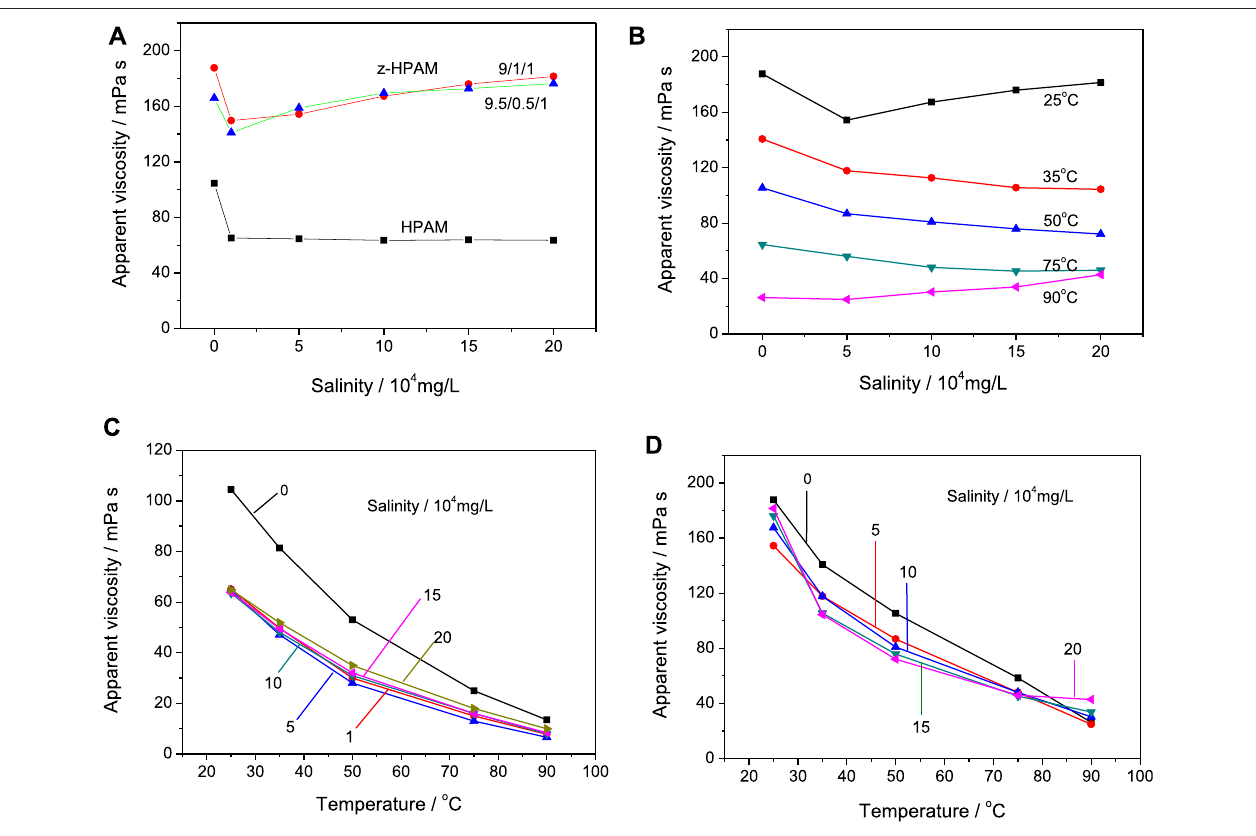
FIGURE3| SolutionviscositychangeofHPAM(n AM /n AA (cid:2) 9/1)andz-HPAM(n AM /n AA /n MDSA (cid:2) 9/1/1or9.5/0.5/1)tosalinity (A) ,thatofz-HPAM(n AM /n AA /n MDSA (cid:2) 9/1/1) to salinity (B) , and that of HPAM (n AM /n AA (cid:2) 9/1) (C) and z-HPAM (n AM /n AA /n MDSA (cid:2) 9/1/1) (D) to temperature.